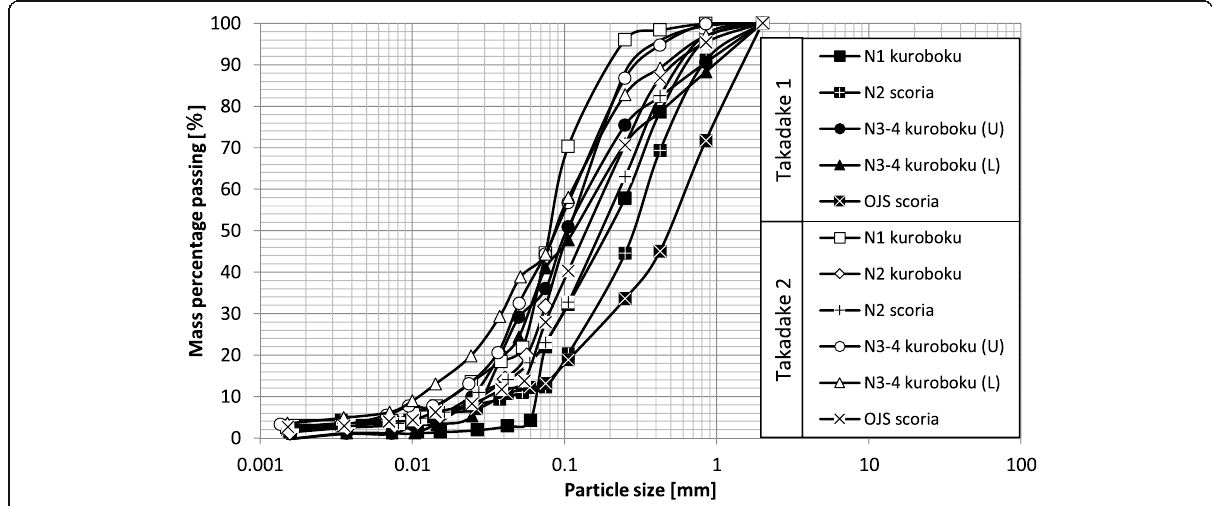
Fig. 3 Particle size distribution curve show that all tephra layers indicate poorly-graded soil material